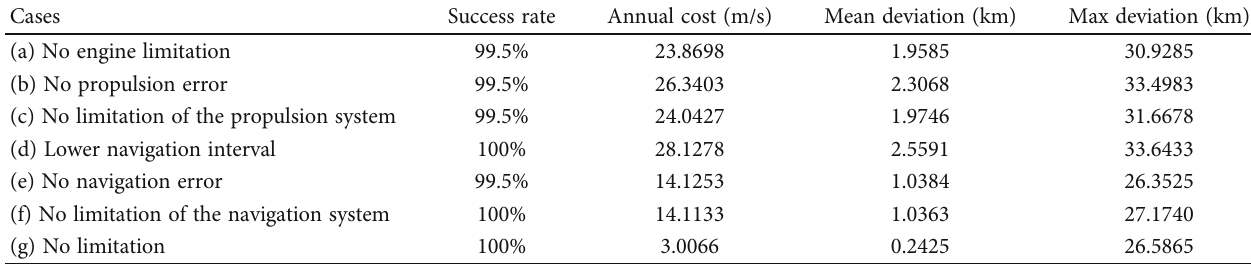
Table 5: The performance indexes of the seven cases for the 9:2 NRHO. Cases